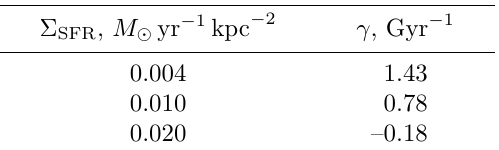
Fig. 2. Magnetic field evolution for the model with random coefficients: Σ SFR = 0 : 004 M ⊙ yr − 1 kpc − 2 (the solid line); Σ SFR = 0 : 01 M ⊙ yr − 1 kpc − 2 (the dashed line), and Σ SFR = 0 : 02 M ⊙ yr − 1 kpc − 2 (the dotted line). Table 1. Growth rate of the magnetic field for different values of Σ SFR